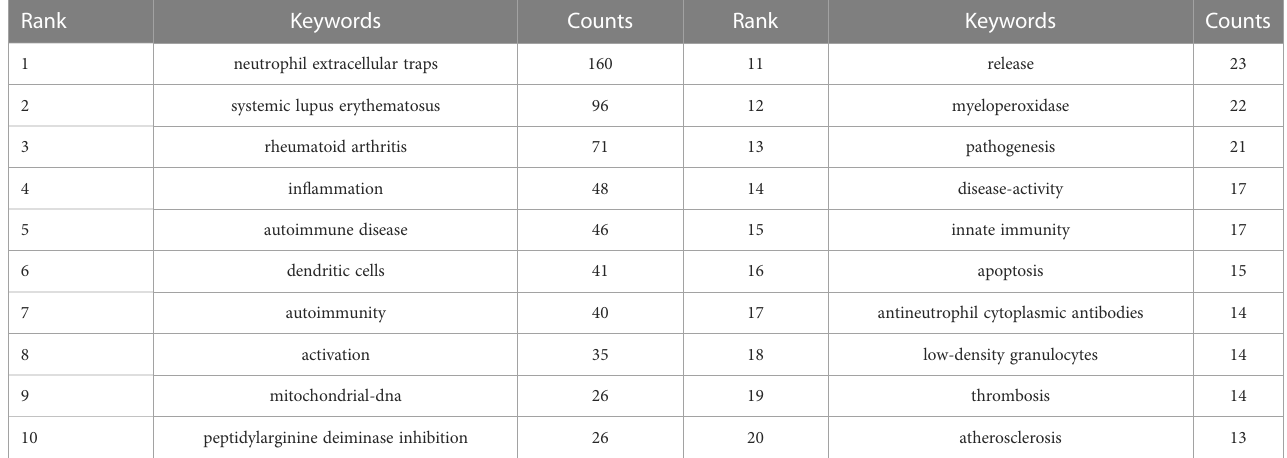
TABLE 6 Top 20 keywords on the research of NETs in